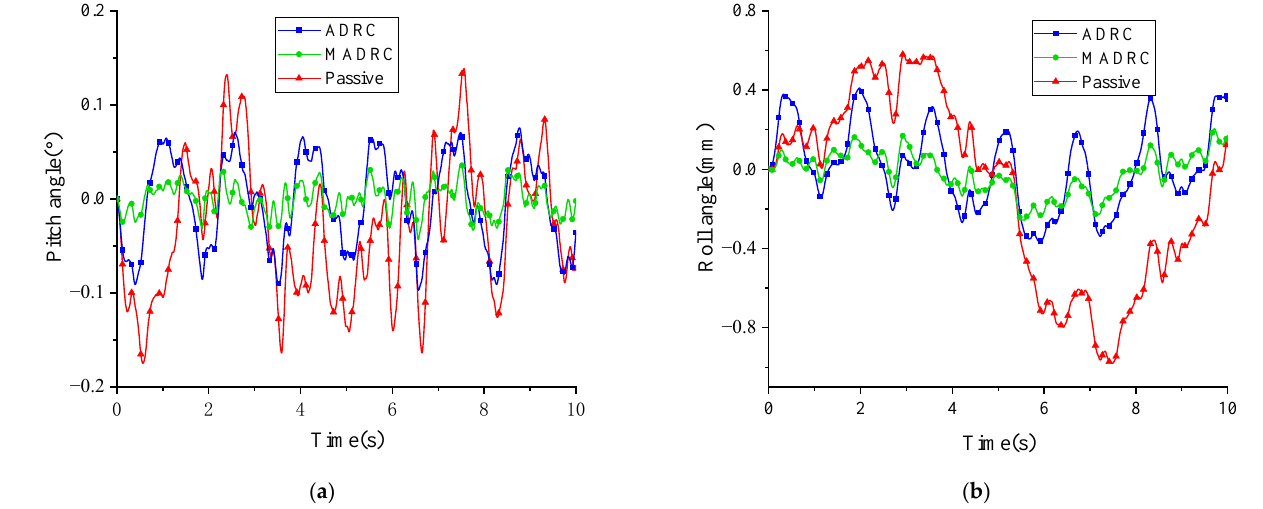
Figure 6. ( a ) Comparison curve of vehicle pitch angle under stochastic signals; ( b ) comparison curve of vehicle roll angle under stochastic signals.